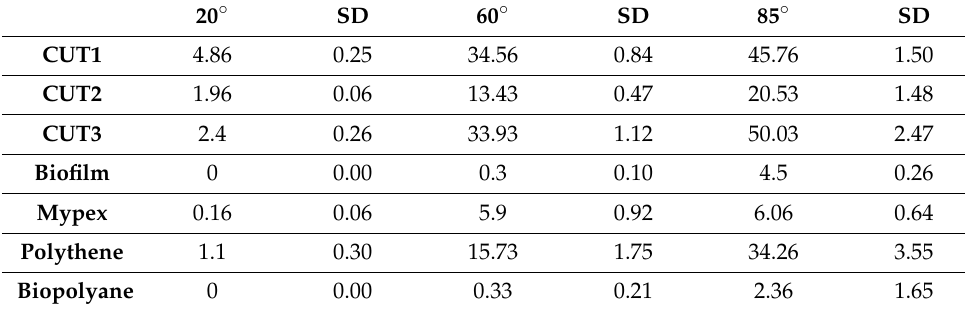
Table 4. Gloss measurement results for geometries 20°, 60°, and 85°.